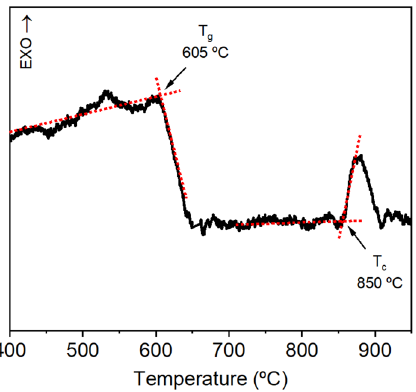
Figure 1. DSC of GPM (10 wt% of Nd 2 O 3 ) glass sample at heating rate of 10 °C/min (T g = glass transition temperature, T c = crystallization